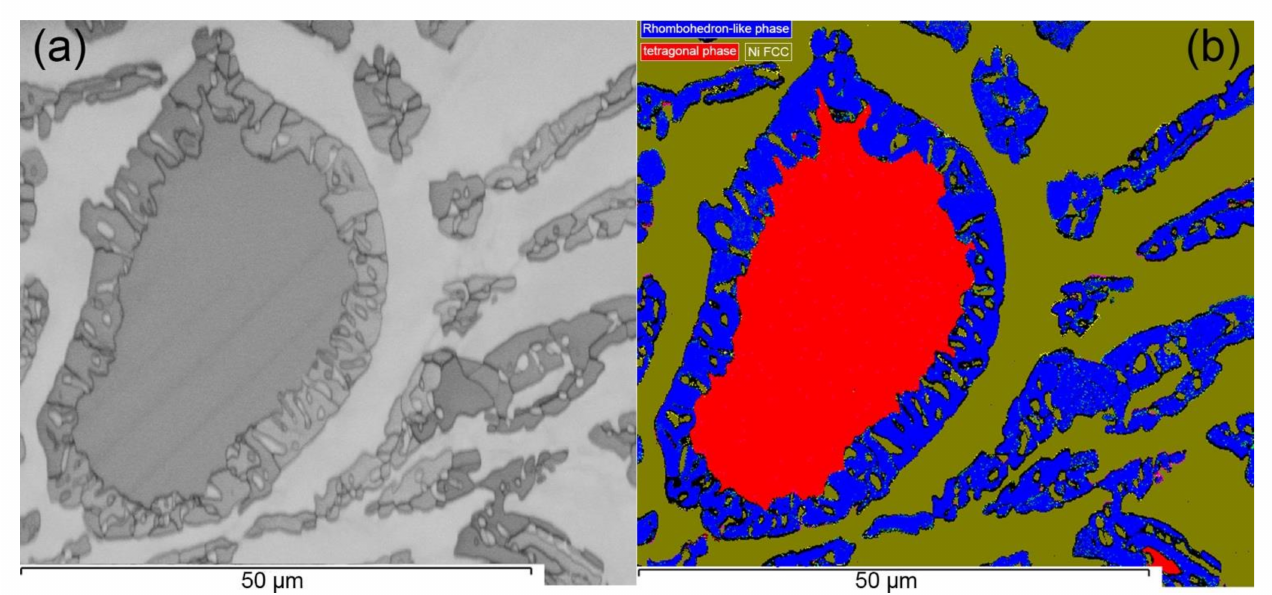
Figure 5. ( a ) Band contrast image of the post-DTA sample (Figure 3e), ( b ) electron backscatter diffraction (EBSD) phase dis- tribution map of the full cycle DTA sample showing FCC phase embedded with tetragonal phase and rhombohedron